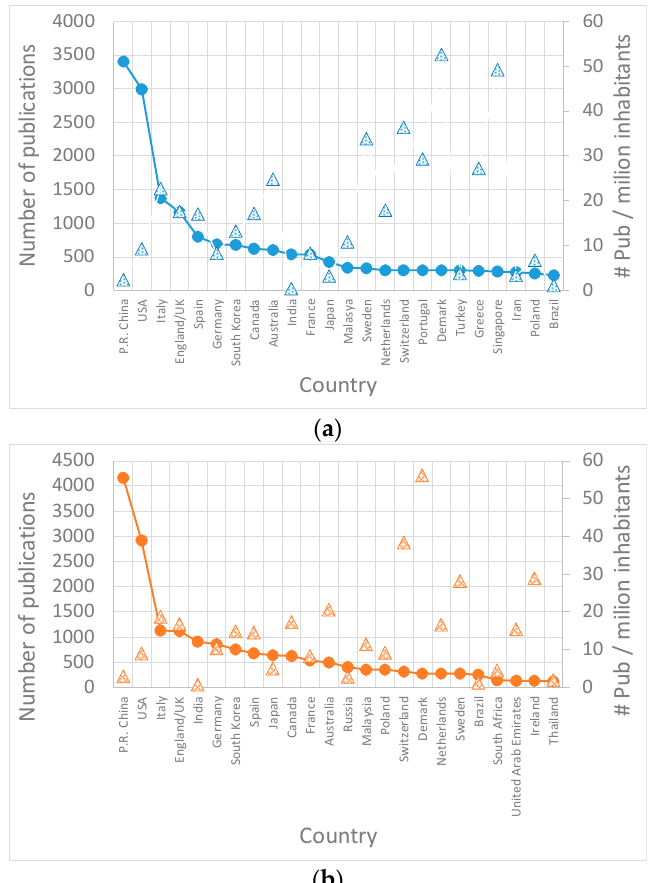
Figure 6. Scientific production per country (continuous line) during the period January 2013–September 2019 and number of publications per million inhabitants (single marker): ( a ) Web of Science; ( b ) Scopus.